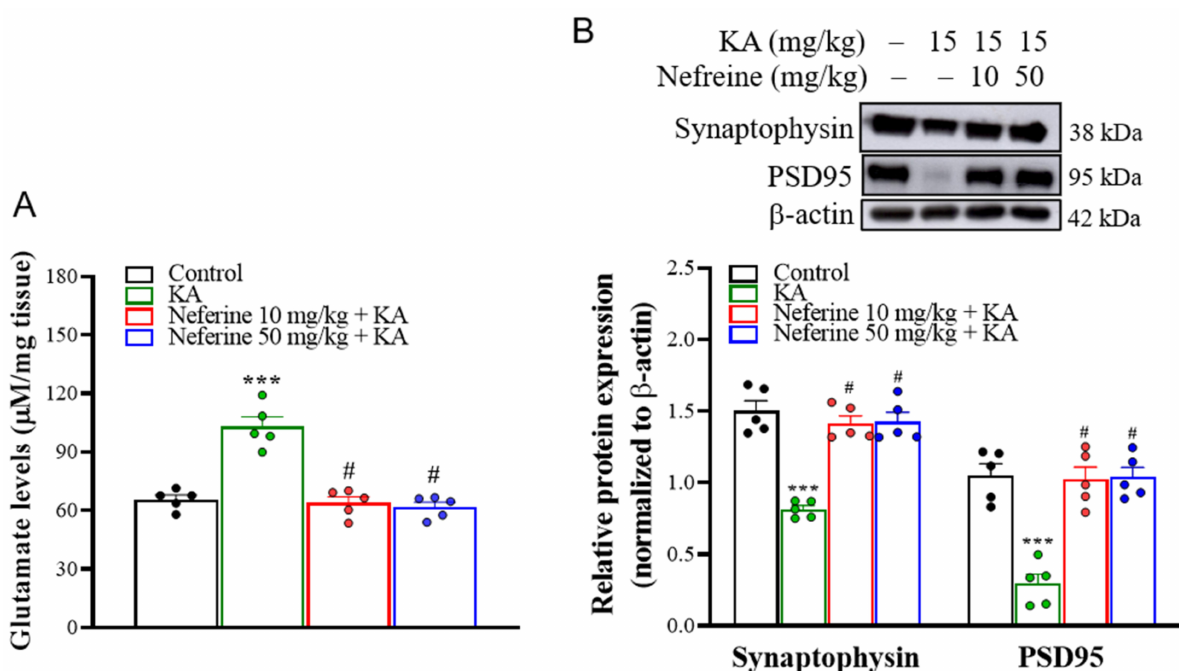
Figure 3. ( A ) HPLC analysis of hippocampal glutamate level in the different groups ( n = 5 rats/group). Results show that neferine reduced the levels of glutamate (one-way ANOVA). ( B ) Western blot analyses of synaptophysin and PSD95 proteins in rat hippocampal tissue. Representative Western blot images in the different groups and densitometric values for synaptophysin and PSD95 were normalized to β -actin levels ( n = 5 rats/group). Statistical results of the immunoblot analysis showed that neferine increased the band intensity of synaptophysin and PSD95 (one-way ANOVA). *** p < 0.05 vs. control group. # p < 0.05 vs. KA-treated